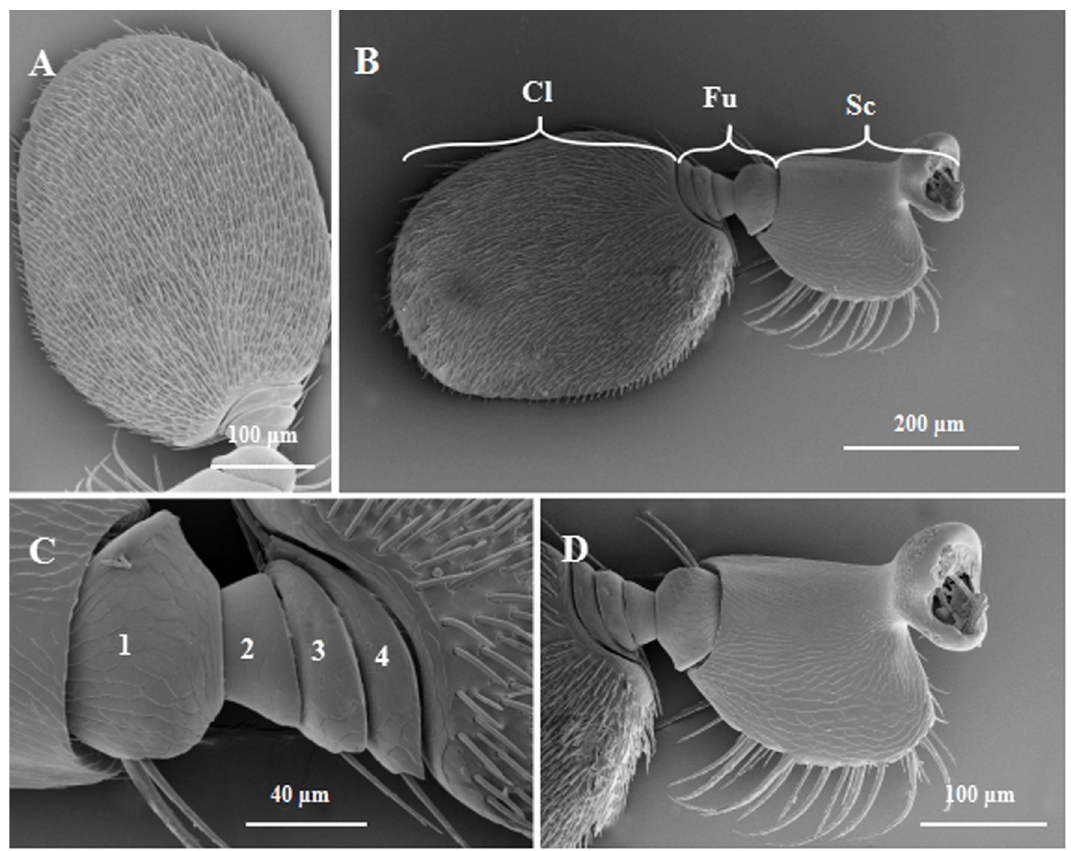
Fig 1. Adult Euplatypus parallelus antennae in dorsal vision. E . parallelus have a geniculate antenna, is sensory appendage on either side of the rostrum, and composed of 6 segments, namely the scape, 4-segmented funicle, and club. The antennae of females are significantly longer than males. A: Geniculated antennae of E. parallelus. B: Club. C: Funicle. D: Scape. Cl: Club; Fu: Funicle; Sc: